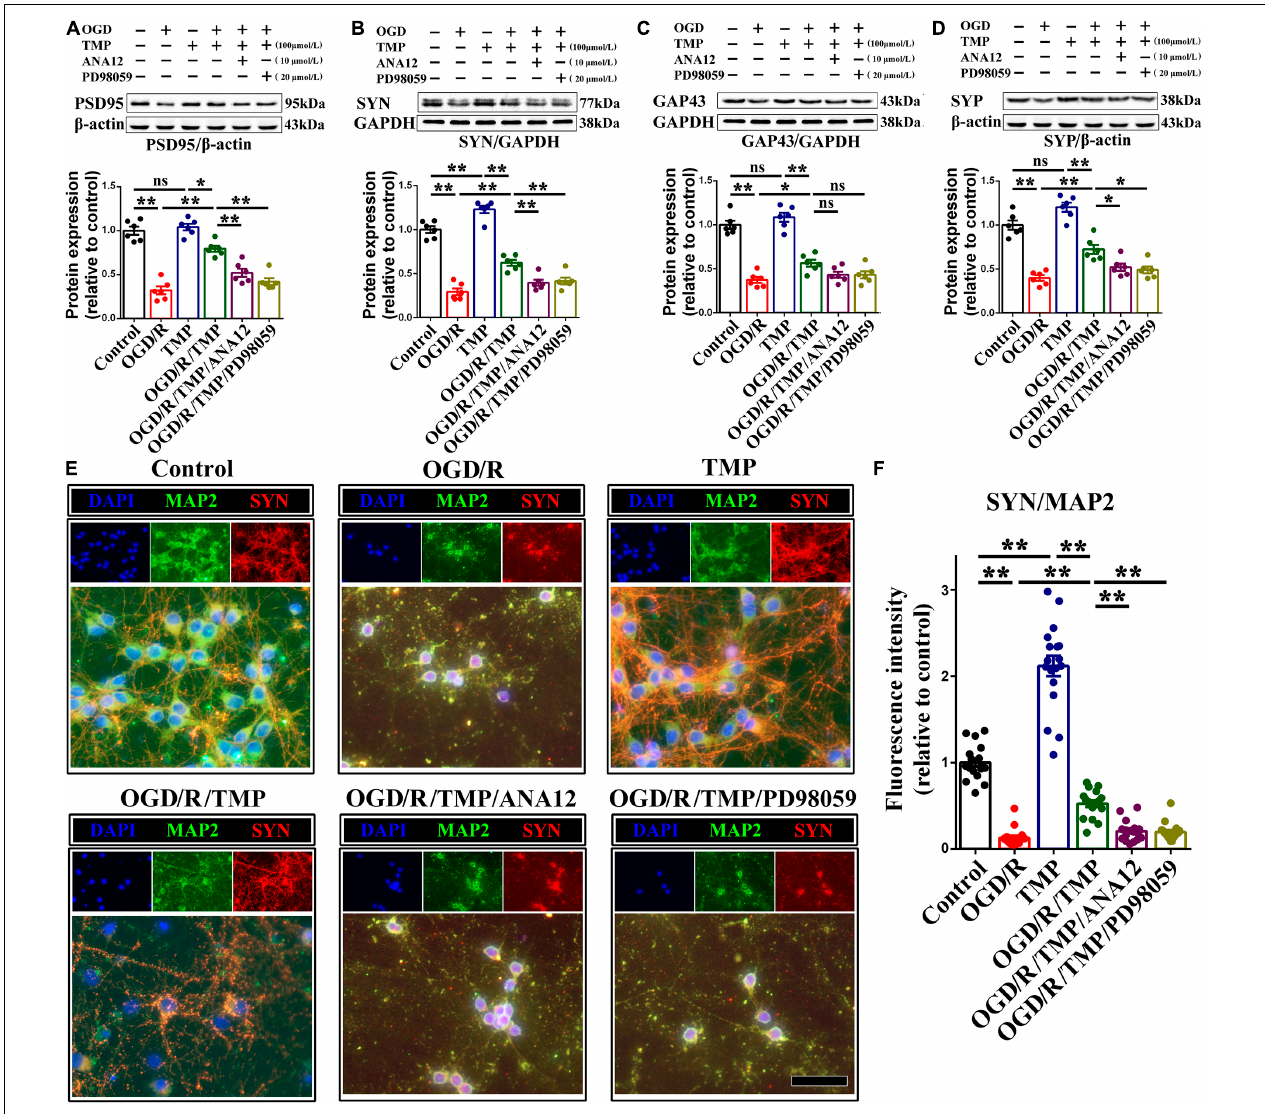
FIGURE 10 | TMP administration increases synapse-associated protein expression in primary cultured neurons under OGD condition. (A–D) Representative immunoblots representing the expression and semi-quantitative analysis of synapse-associated proteins including PSD-95 (A) , SYN (B) , GAP-43 (C) , and SYP (D). (E) Representational immunostaining of co-labeling of MAP2 (green) and SYN (red) in primary neurons under different groups. Nuclei were counterstained with DAPI. Scale bar: 50 µ m. (F) Bar graph illustrating the optic intensity of SYN in different groups. Data are presented as mean ± SE. n = 6 per group, * P < 0.05, ** P < 0.01.